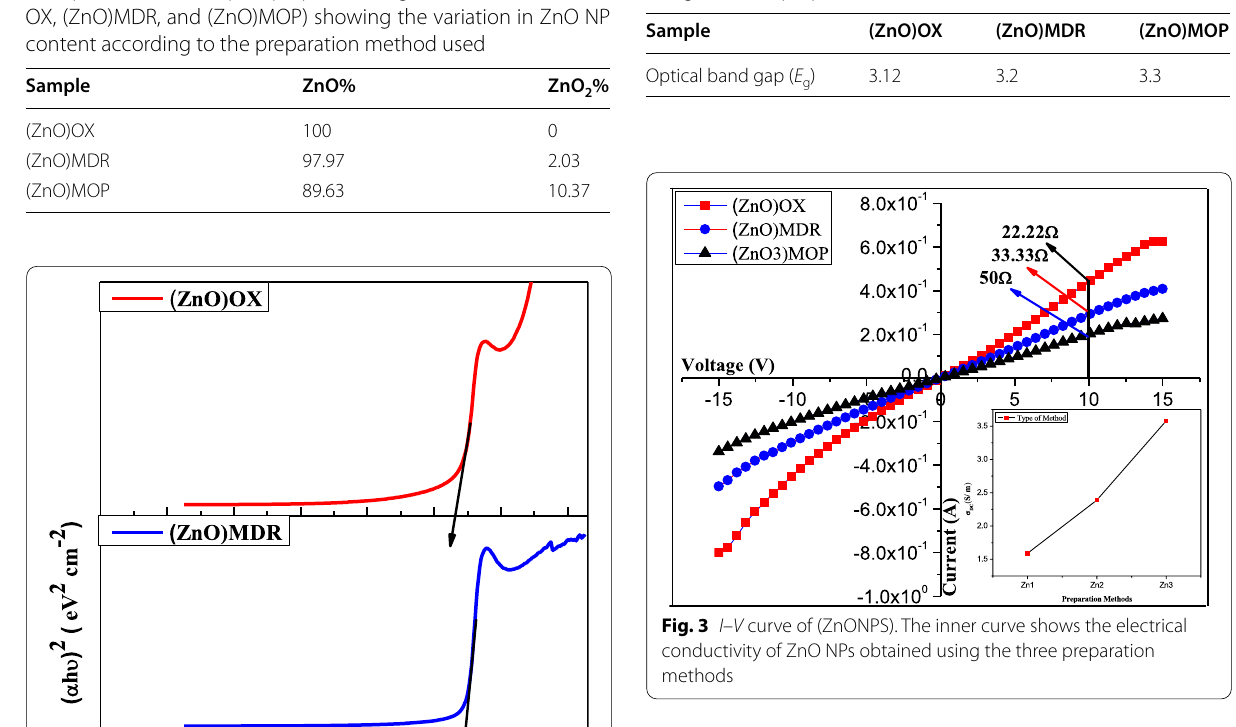
Figure 1c represents the TEM image of ZnO NPs pre- pared using the OX method ((ZnO)OX). These ZnO NPs obtained using the (ZnO)OX method were almost with a mean size of 35 nm 10 nm because the creation ± tion (Fig. 1c).